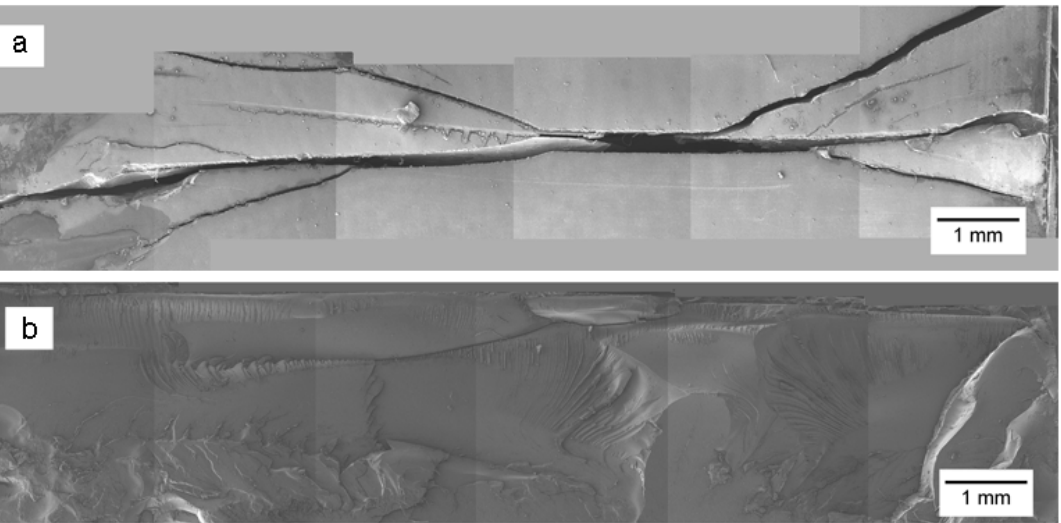
Figure 8. Stitched SEM microstructure of the PC after the ESC test at high pre-strain and in the presence of DOP oil: ( a ) Surface crack profile; ( b ) fractured cross-section.